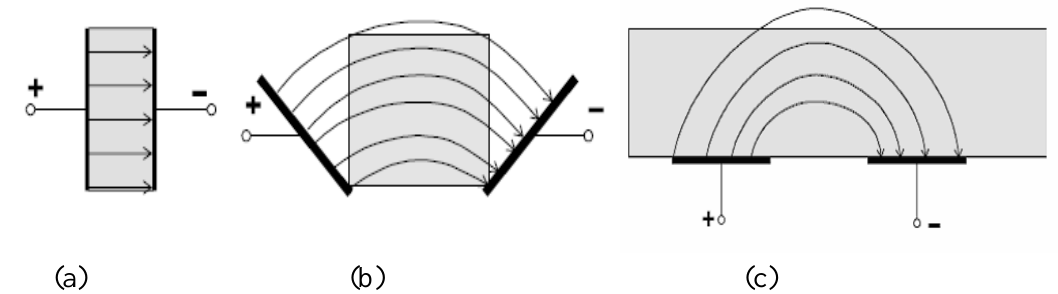
Figure 5. Operating principle of an interdigital